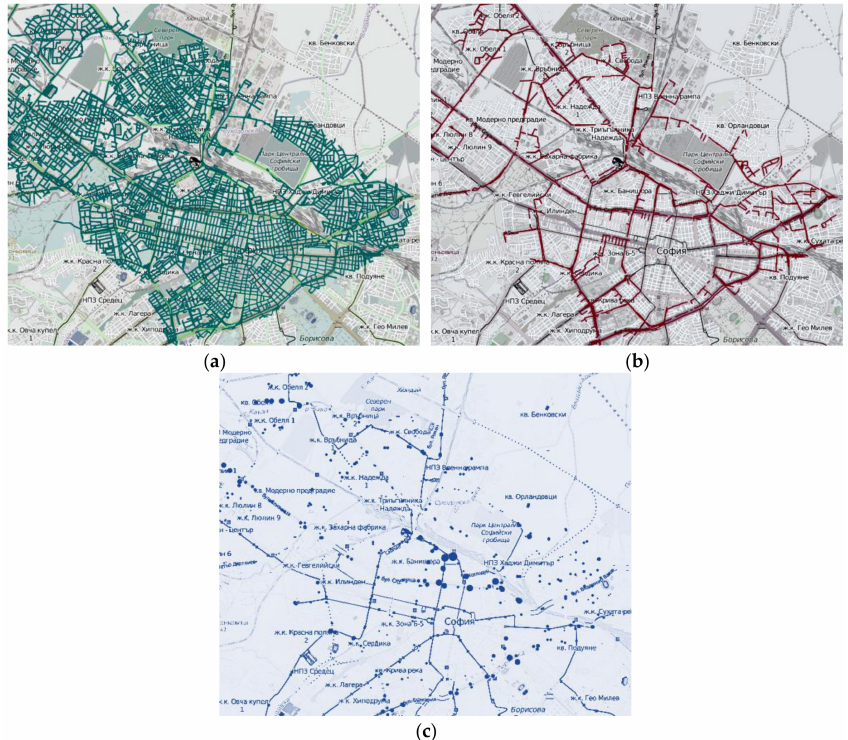
Figure 11. ( a ) Road segments; ( b ) public transport segments; and ( c ) public transport stops (clockwise from top-left) overlaid on Sofia Open Street Map, where the segments represent